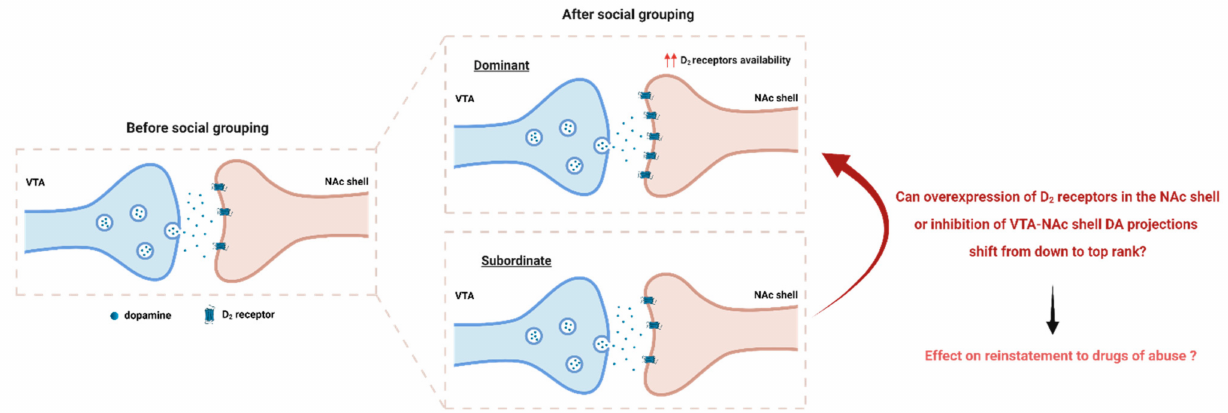
Figure 2. Effect of social grouping on VTA to NAc shell dopaminergic signaling. After social grouping, dominant individuals exhibited higher D 2/3 receptor availability in the NAc shell [14]. However, D 2/3 receptor availability was unchanged in subordinates [13]. Higher D 2/3 receptor binding observed in dominant animals might be due to higher D 2/3 receptor levels or reduced DA release. Can overexpression of D 2 receptors in the NAc shell or inhibition of VTA-NAc shell projections shift a subordinate susceptible profile to a dominant resilient profile? What is the subsequent effect of this shift on reinstatement to drugs of abuse? Tackling this question would uncover the cause of higher D2/3 receptor binding observed in dominant animals. VTA, ventral tegmental area; NAc shell, nucleus accumbens